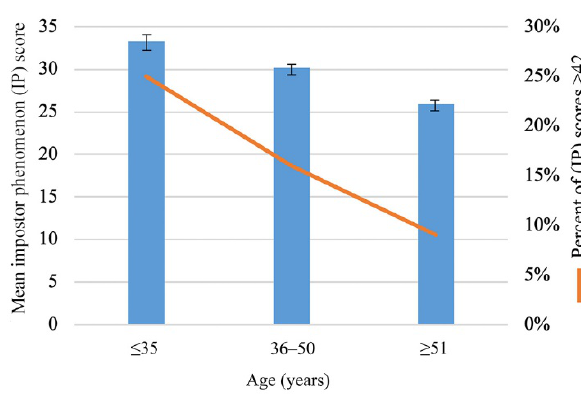
Figure 2 Comparison of differences in impostor scores by years of experience